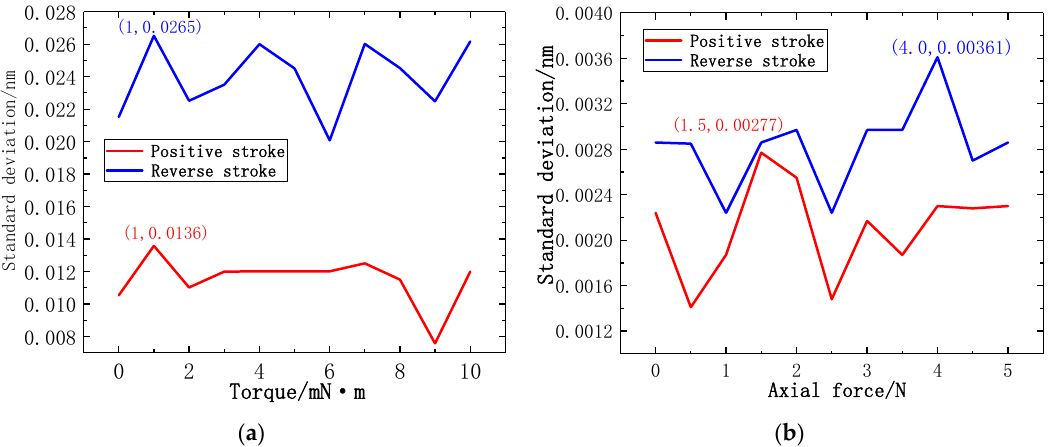
Figure 16. Line chart of standard deviation: ( a ) Standard deviation of torque; ( b ) Standard deviation of axial force.